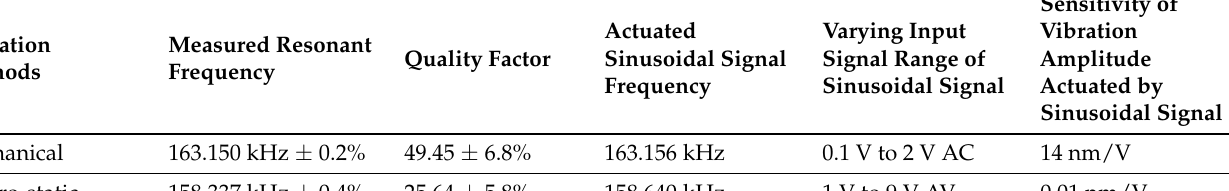
Table 1. The dynamic characteristics of graphene/PMMA closed cavity ultrasonic sensor.